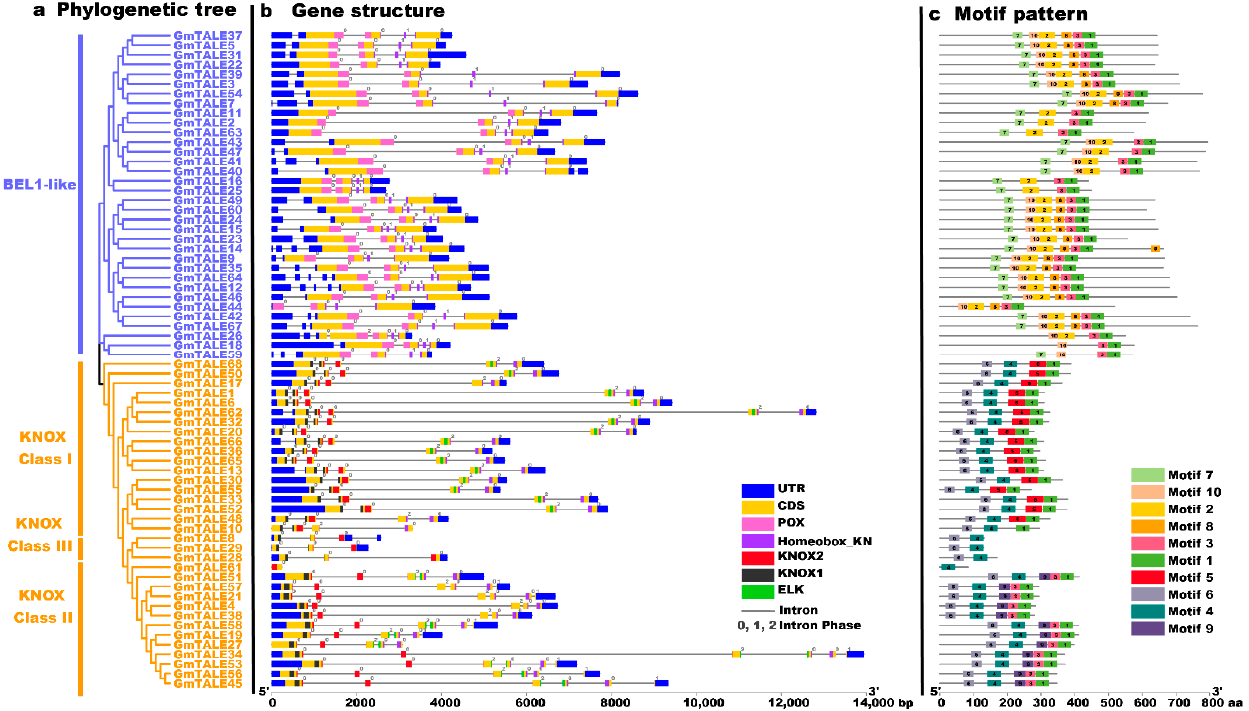
Figure 2. Phylogenetic relationships, gene structures and motif patterns of GmTALE members. ( a ) Phylogenetic clustering of GmTALE members. The phylogenetic tree was as built used the maximum likelihood (ML) method with the best scoring JTT + G model. ( b ) Gene structures of GmTALE genes. Blue boxes represent the untranslated 5 ′ - and 3 ′ -regions; yellow boxes indicate exons; black lines indicate introns. The numbers (0, 1, 2) indicate the phases of the introns. The diverse conserved domains were represented with different colored boxes. ( c ) The motif patterns GmTALE members. Besides, the length of relevant gene structures and motif components can be estimated with respective scales at the bottom of panels.